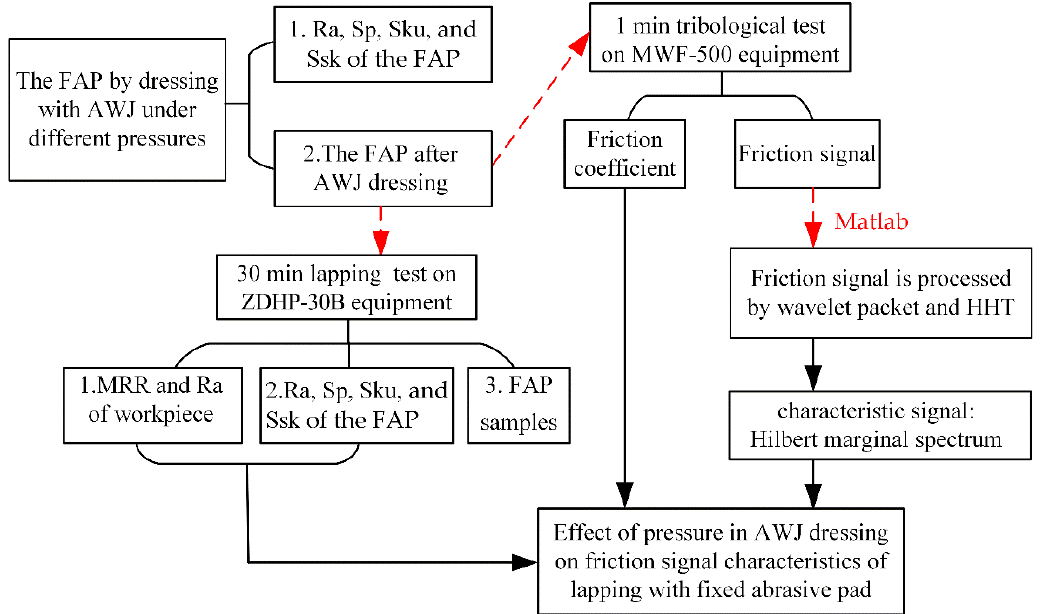
Figure 5. Experimental process diagram.